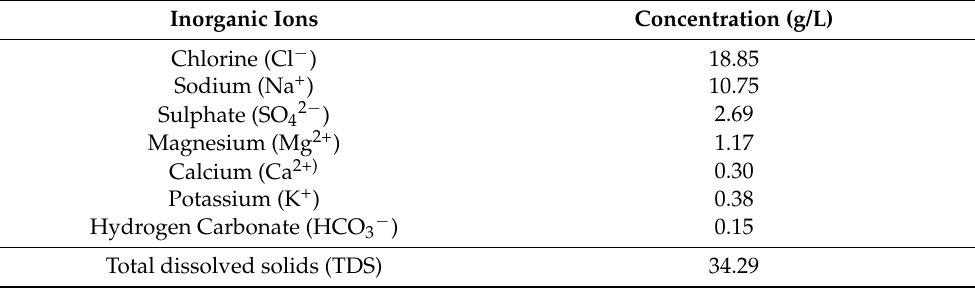
Table 2. Inorganic ion composition of model artificial seawater (ASW).